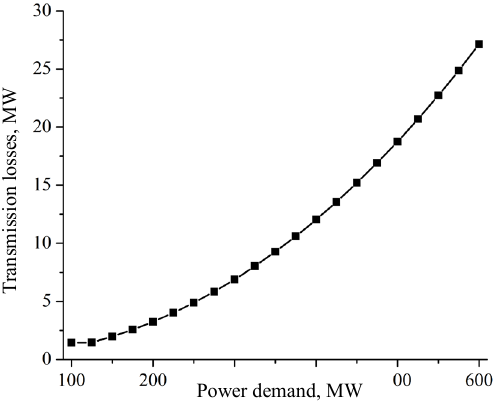
Fig. 7. Power demand vs transmission losses.